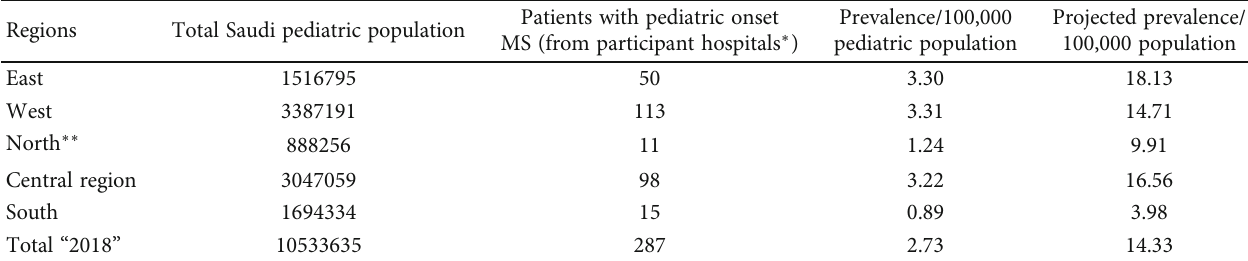
Table 2: Total Saudi pediatric population and prevalence of pediatric MS among Saudi pediatric